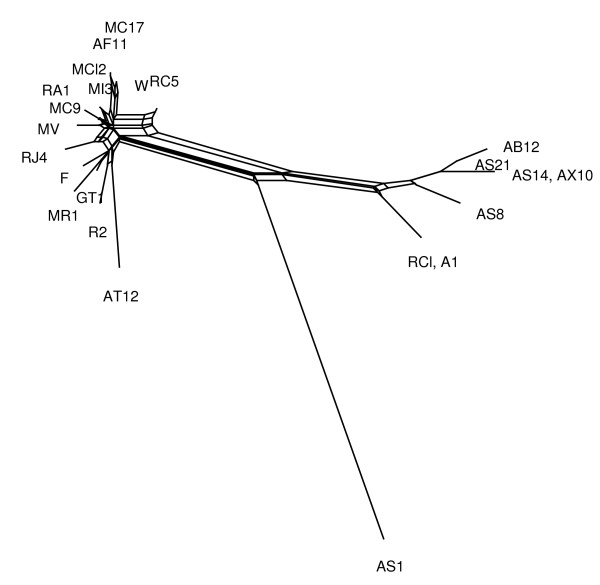
The MC-Net network for the Rubber data set.